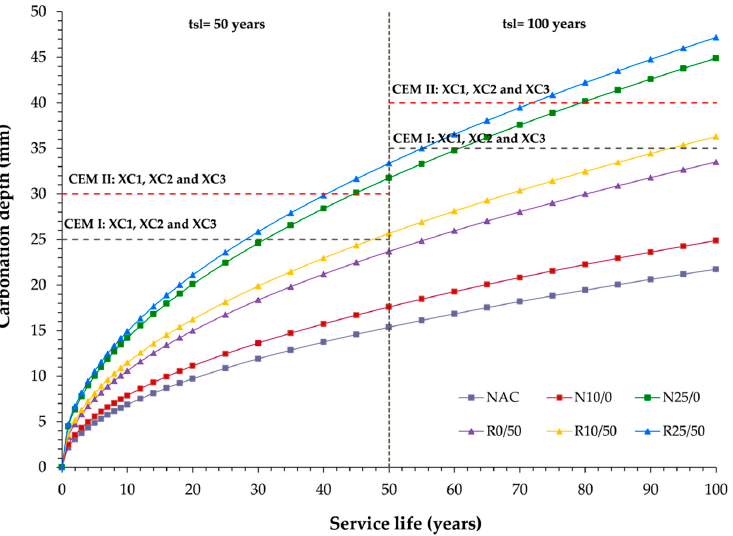
Figure 6. Service life model proposed in Spanish concrete code EHE-08 for carbonation spread in concrete